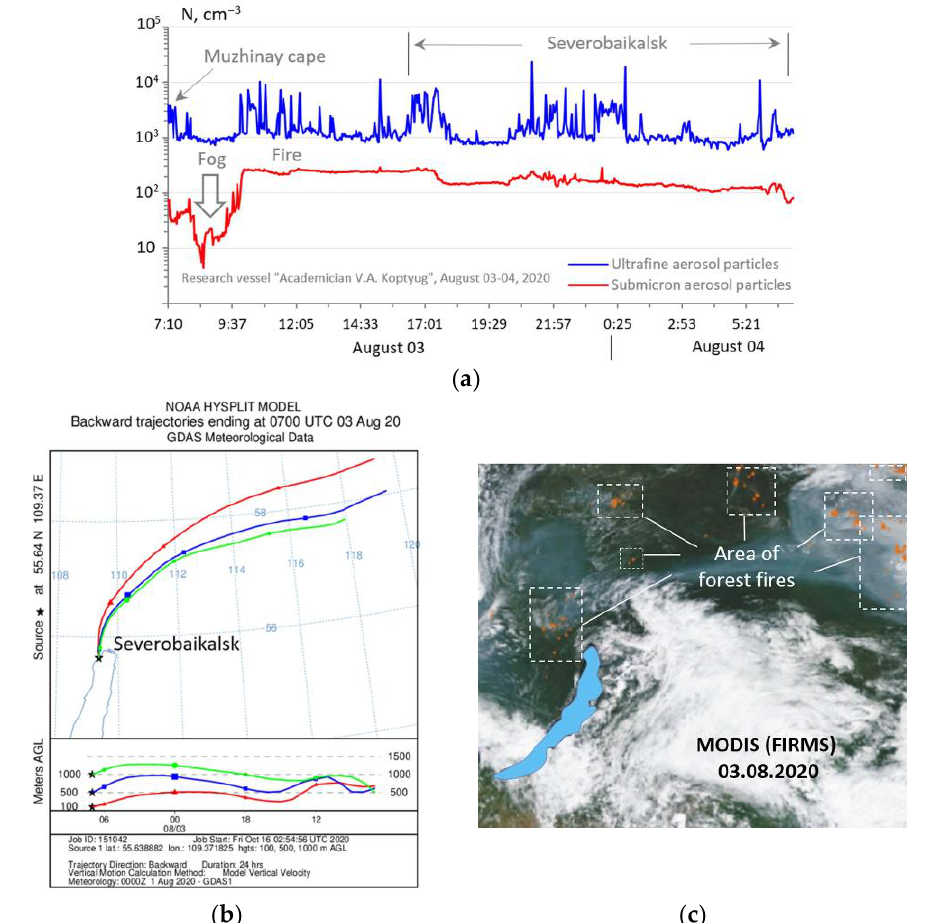
Figure 7. Temporal variation of concentration of aerosol particles in the driving layer of Lake Baikal during fog and smoke emission in the period of 3–4 August 2020 ( a ); reverse trajectories of movement of air masses according to the HYSPLIT model ( b ); and map of wildfires according to MODIS satellite data ( c ).